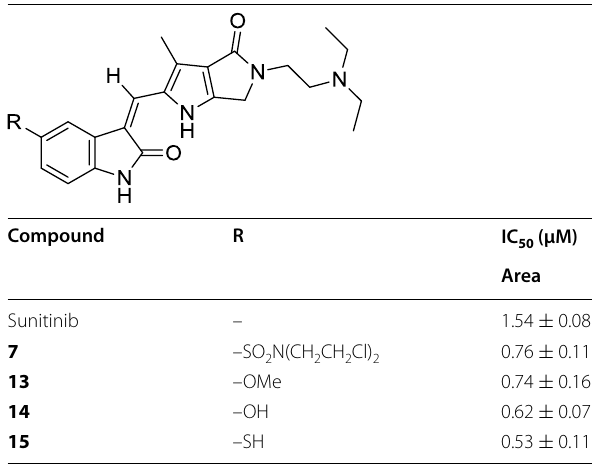
Table 3 Inhibition activities of 7, 13–15, and sunitinib against in vitro tube